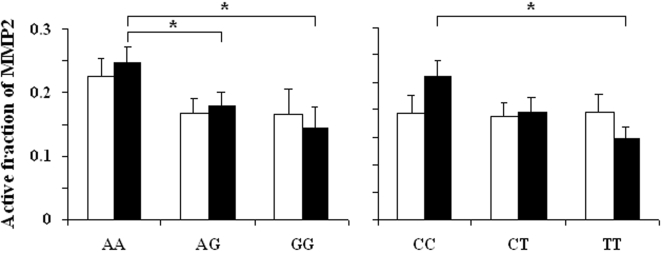
Association between MMP16 polymorphisms (A: rs2664349 A/G; B: rs2664352 C/T) and the size of the activated fraction of MMP2 measured in tracheal aspirates.Aspirates were collected immediately after birth (open bars), and between 1 and 3 days of life (closed bars). * p<0.05 in post-hoc analysis.